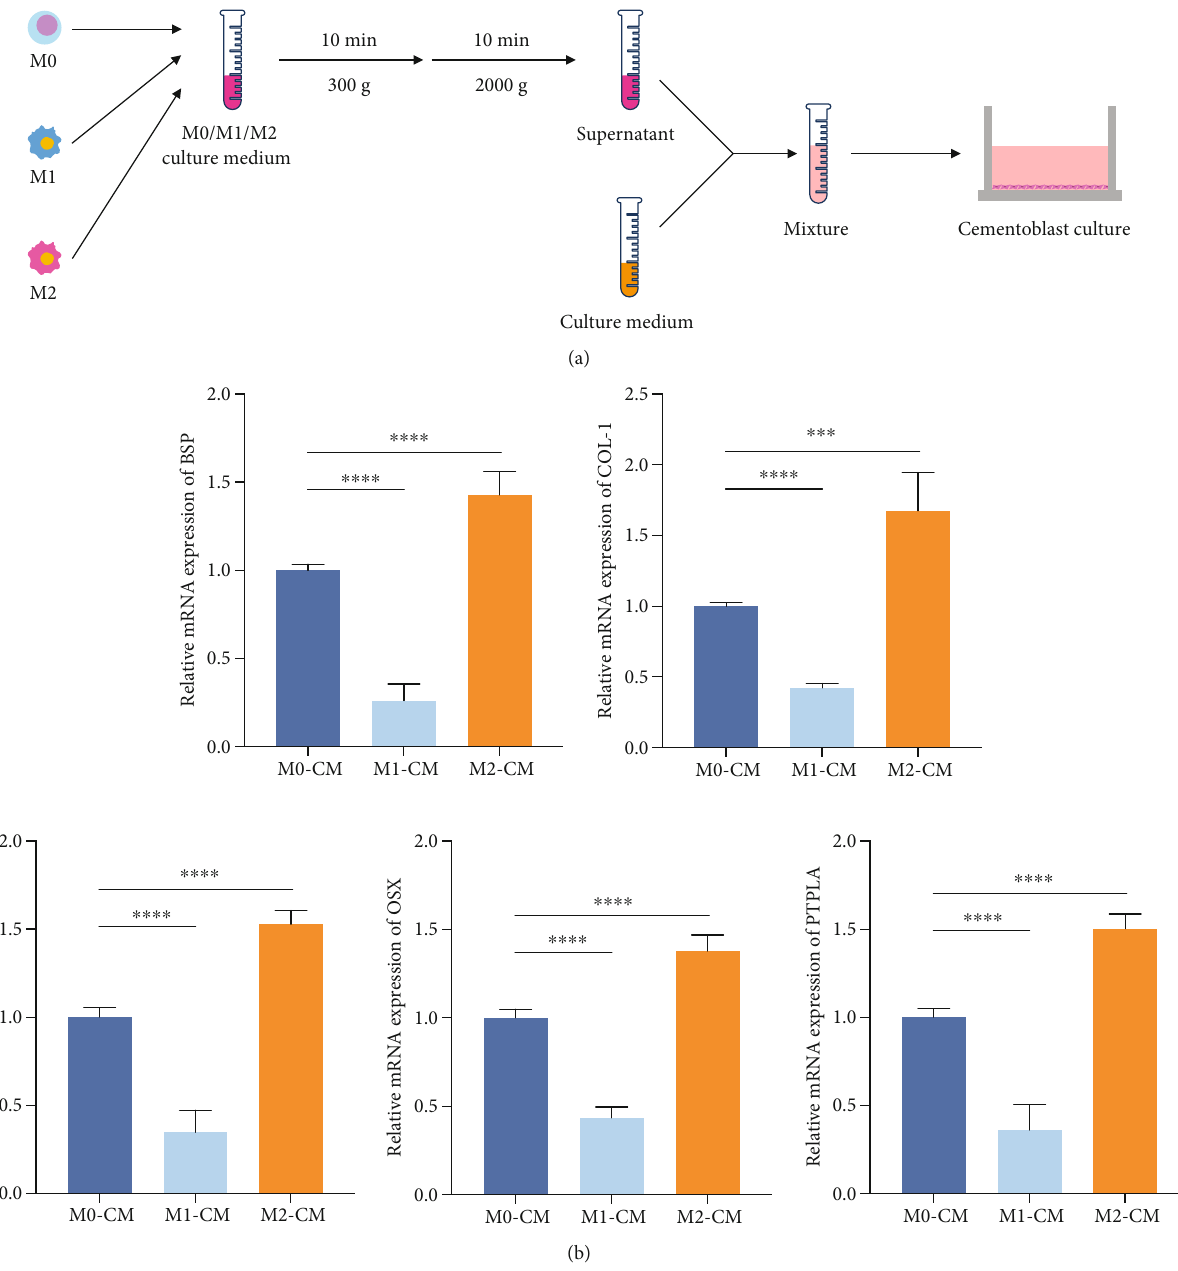
Figure 3: Macrophages with di ff erent polarization phenotypes in fl uenced cementoblast mineralization in the conditioned medium-based coculture system. (a) Diagram of the conditioned medium-based coculture system of cementoblasts and M0 and M1- and M2-polarized macrophages. (b) The mRNA expression levels of BSP, COL-1, RUNX2, OSX, and PTPLA in cementoblasts after a 3-day coculture with the supernatant of M0, M1, or M2 (referred to as M0-CM, M1-CM, and M2-CM). ∗ P < 0 : 05 , ∗∗ P < 0 : 01 , ∗∗∗ P < 0 : 001 , and ∗∗∗∗ P < 0 : 0001